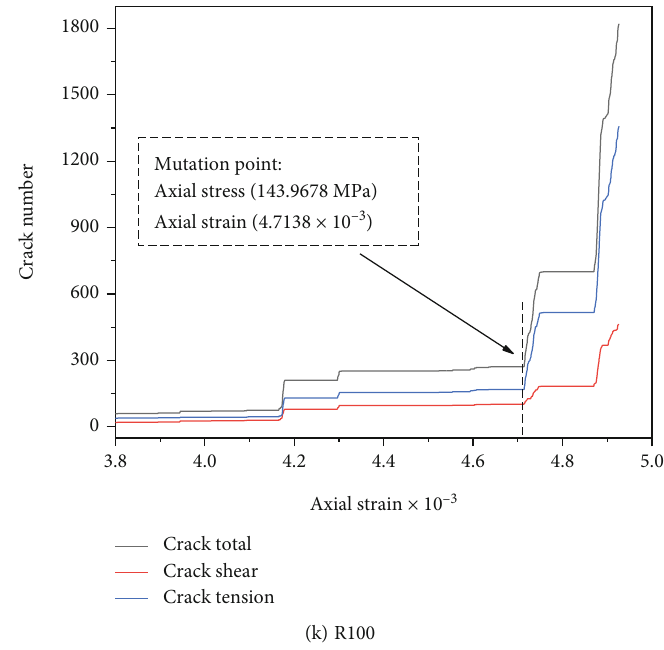
Figure 17: Crack number evolution curve.